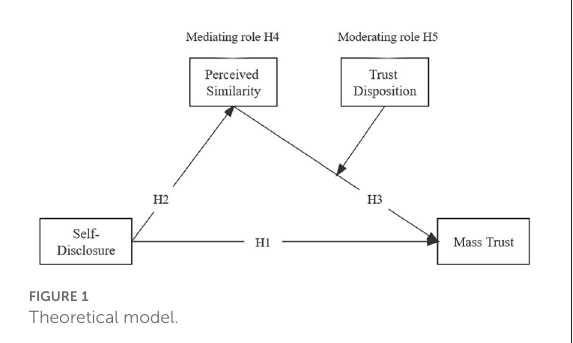
FIGURE1 Theoretical